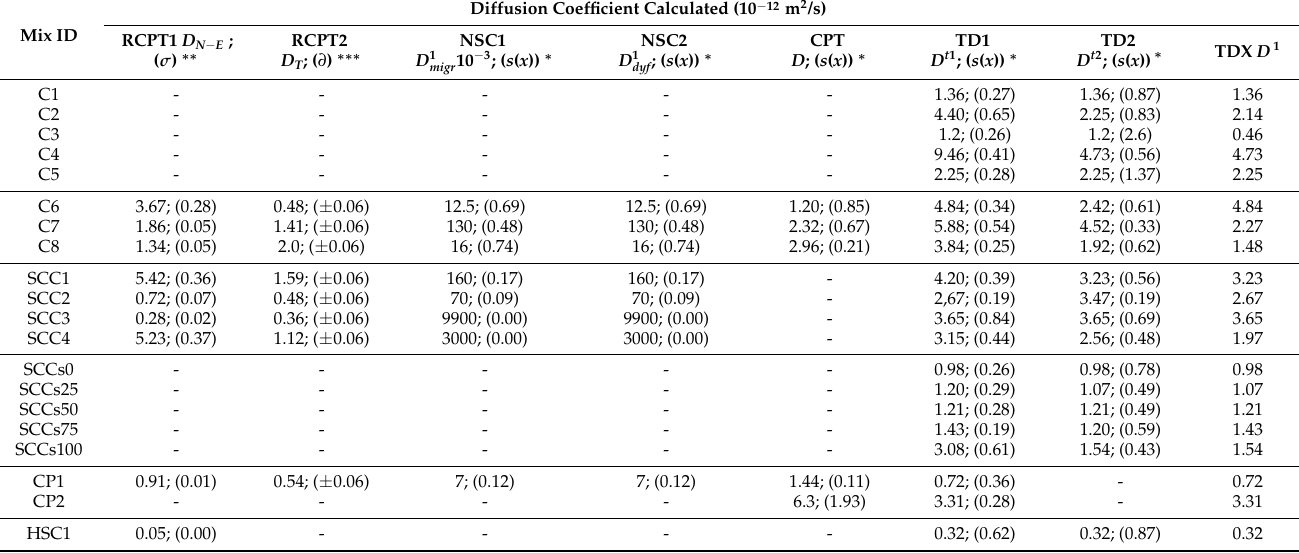
Table 8. Diffusion coefficient calculated based on the standards and the thermodynamic model of migration for relating concretes.